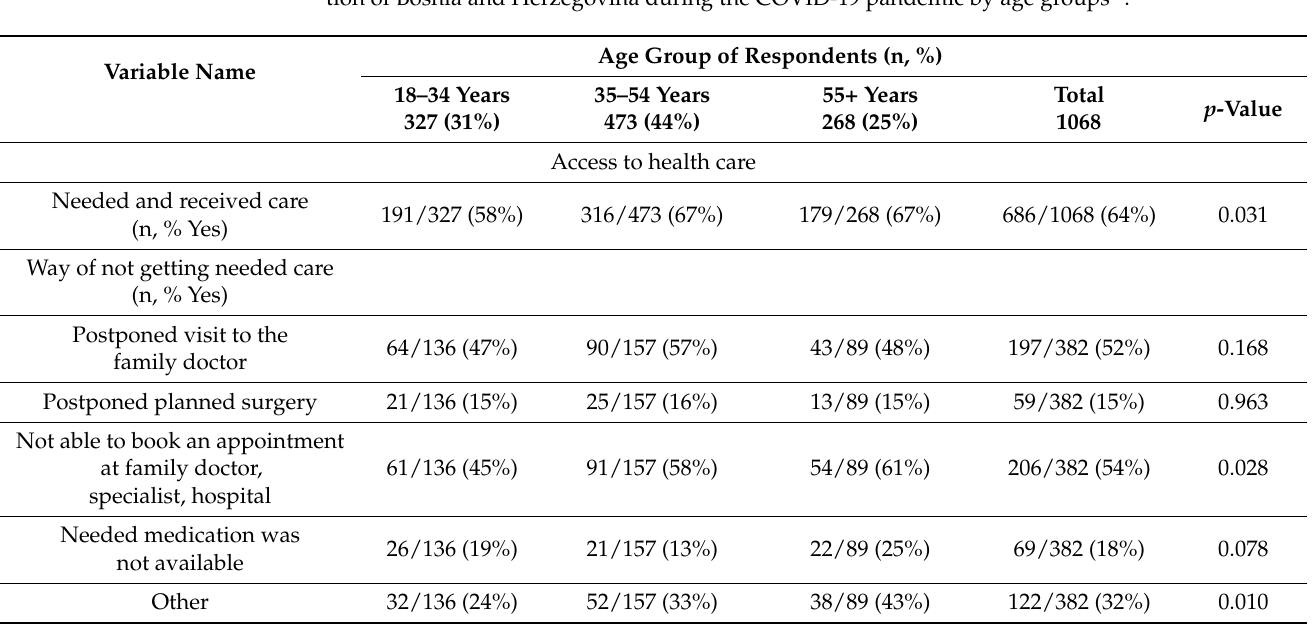
Table 4. Self-perceived access to care, postponements of care, and mental health in the adult popula- tion of Bosnia and Herzegovina during the COVID-19 pandemic by age groups